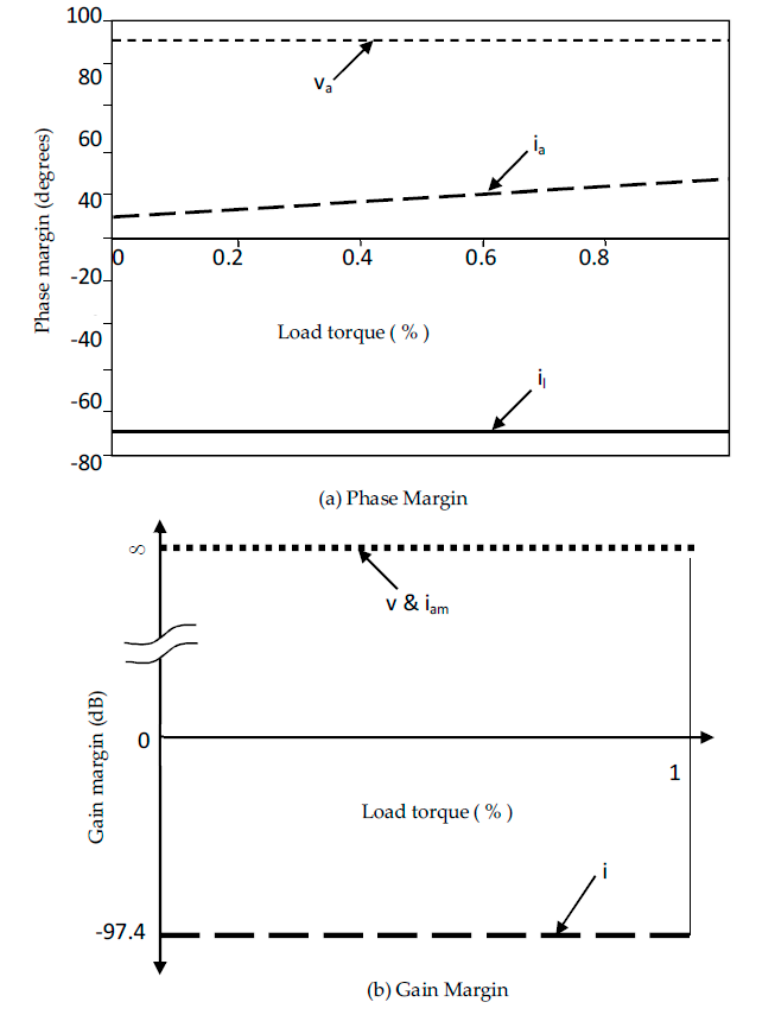
Figure 4. Frequency domain analysis of a fourth-order system. ( a ) Gain Margin ; ( b ) Phase Margin . Comparison of ETEDPOF and PIC